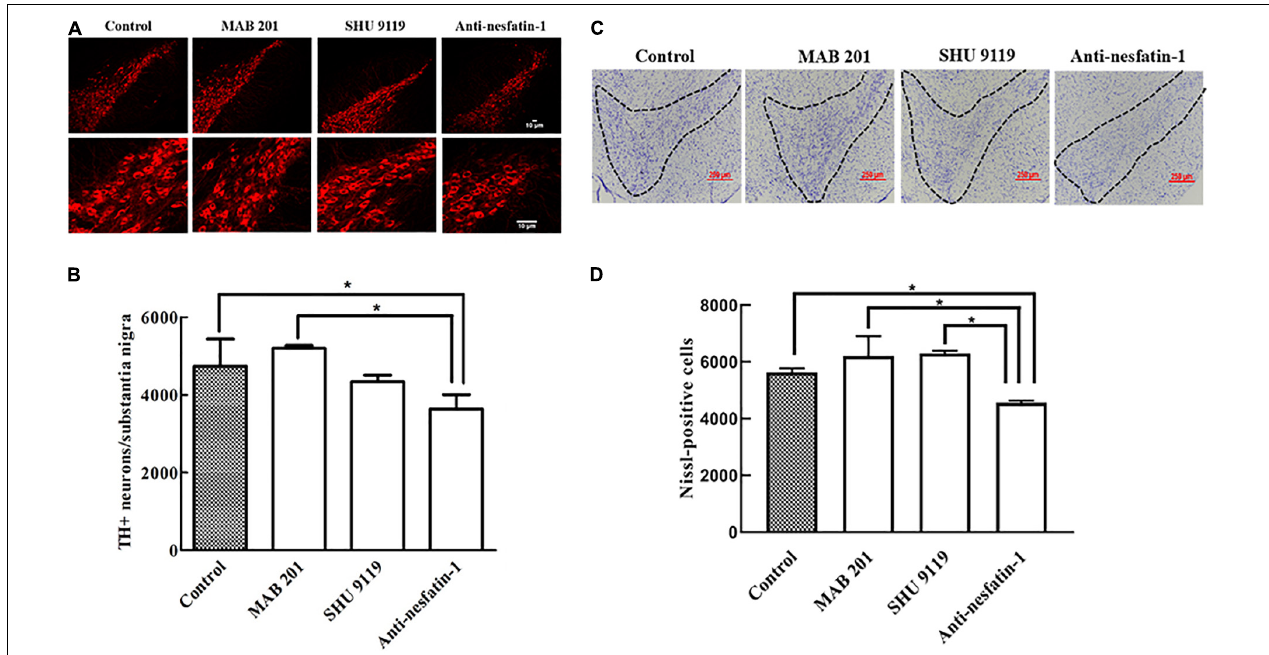
FIGURE 3 | Anti-nesfatin-1 treatment induced nigral dopaminergic neuron degeneration. (A) TH( + )-dopaminergic neurons in the SNpc of control mice and mice treated with MAB 201, SHU 9119, or anti-nesfatin-1 antibody are shown. (B) A summary of the data showing the numbers of TH( + )-dopaminergic neurons in the different groups (TH, tyrosine hydroxylase). (C) Nissl-positive neurons in control mice and mice treated with MAB 201, SHU 9119 or anti-nesfatin-1 antibody are shown. The dotted portion indicates the SNpc. (D) A summary of the data showing the numbers of Nissl-positive neurons in the different groups. Each value represents the mean ± SD, n = 6; * p < 0.05. MAB 201, non-immune anti-mouse IgG antibody; SHU 9119, MC4R receptor inhibitor; SNpc, substantia nigra pars compacta; TH( + ), TH-positive.